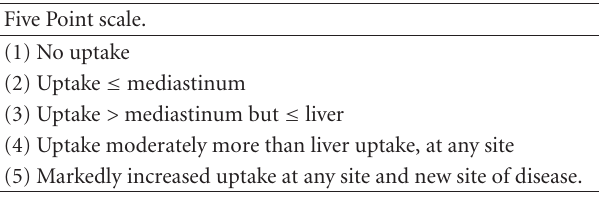
Table 2: Example of cut-o ff for therapy (a) decrease in localised cHL, (b) increase in advanced